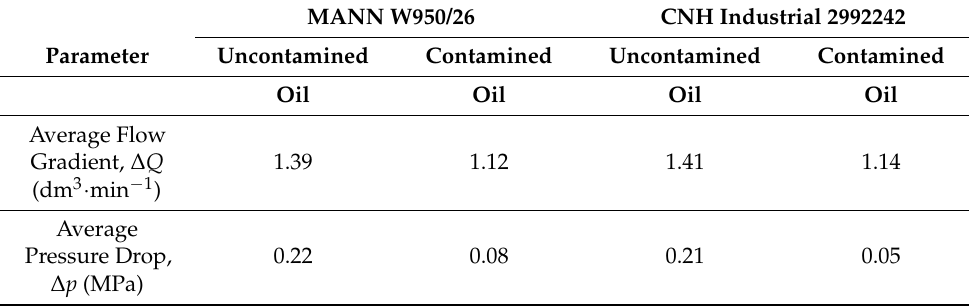
Table 4. Results from the laboratory test equipment